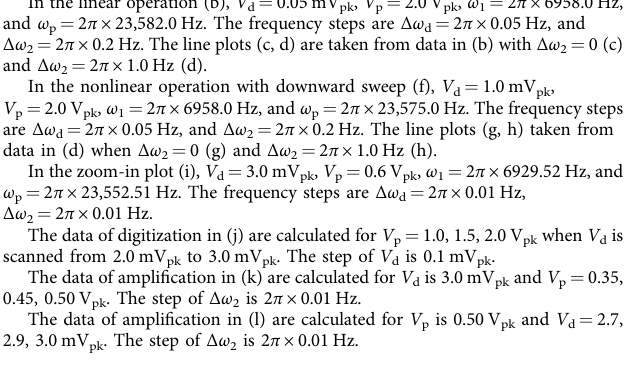
Experimental demonstration of digitization and ampli fi cation functions using PLL . The measurement settings for producing Fig. 5 are as follows: In the nonlinear operation at blue pump with downward sweep (a), V d = 1.25mV pk , V p = 1.5V pk , ω 1 = 2 π ×6538.0 Hz, and ω p = 2 π ×23,048.0 Hz. The steps are Δ ω d = 2 π × 0.02Hz, and Δ V f = 0.05V pk . When using PLL to test the phonon-cavity system at blue pump (b),